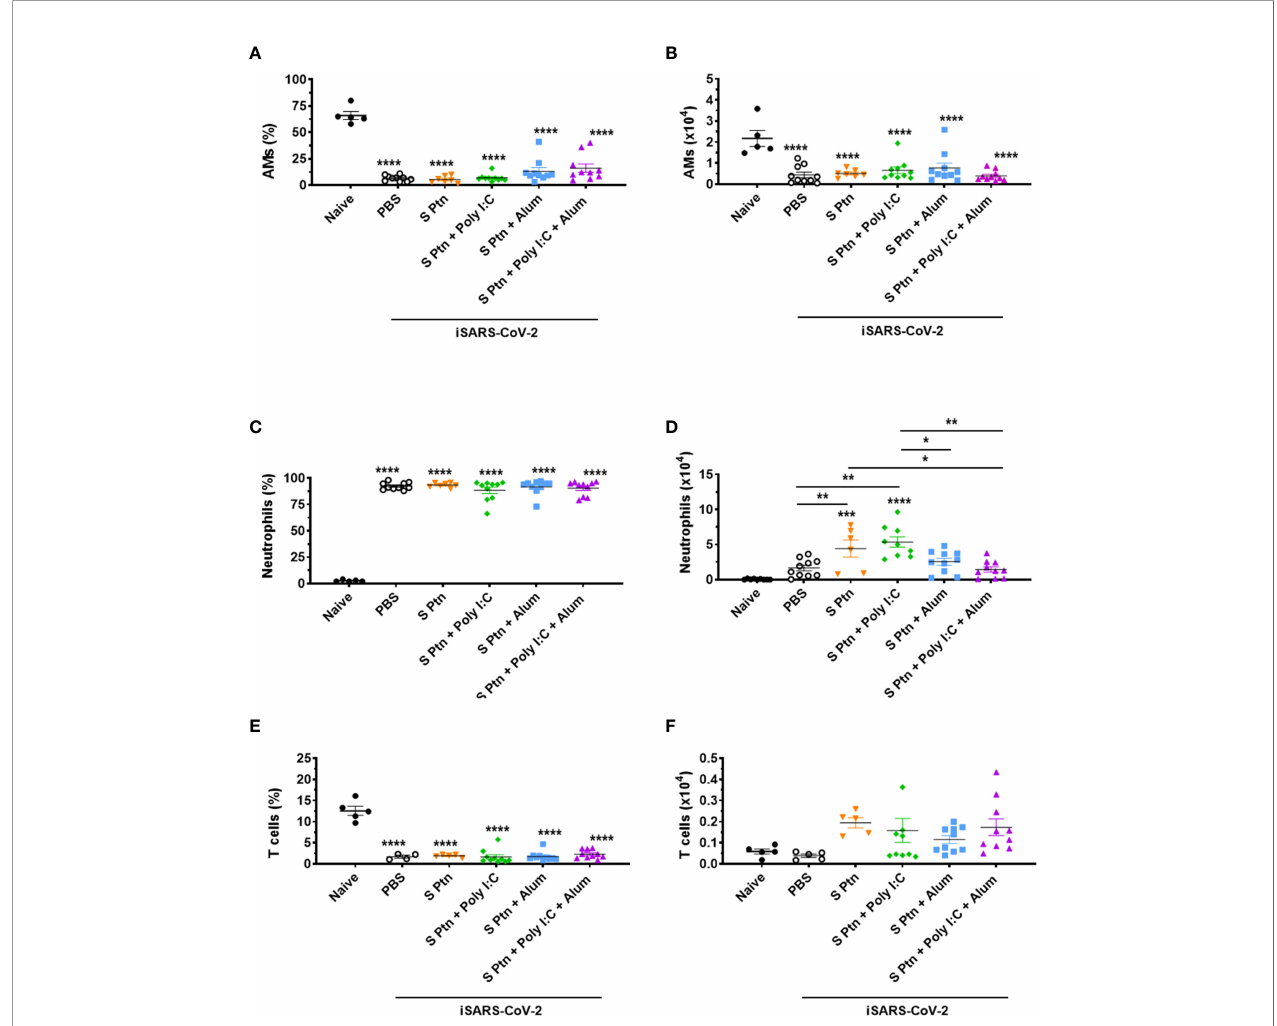
FIGURE 7 | Analysis of BALF immune cell content in mice immunized with S Ptn together with different adjuvants following challenge with inactivated SARS-CoV-2 virus. BALF cells were collected 24 hours after inactivated SARS-CoV-2 (iSARS-CoV-2) virus challenge. The percentage and number of AMs, neutrophils, and T cells from naïve and mice immunized with S Ptn and different adjuvant combinations as gated on fl ow cytometry plots using markers including SiglecF, CD11c, CD11b, Ly6G, Ly6C, and TCR b . Percentage of (A) AMs (CD11b + CD11c - Ly6c hi F4/80 + ), (C) Neutrophils (CD11b + CD11c - Ly6c + F4/80 - ), and (E) T cells (CD11b + CD11c - Ly6c + F4/80 - ) in the BALFs. Absolute numbers of (B) AMs, (D) Neutrophils, and (F) T cells in the BALFs. Data are presented as the mean ± SEM of three pooled experiments and analyzed by one-way ANOVA with Tukey ’ s post hoc test, *p<0.05, **p<0.01, ***p<0.001,